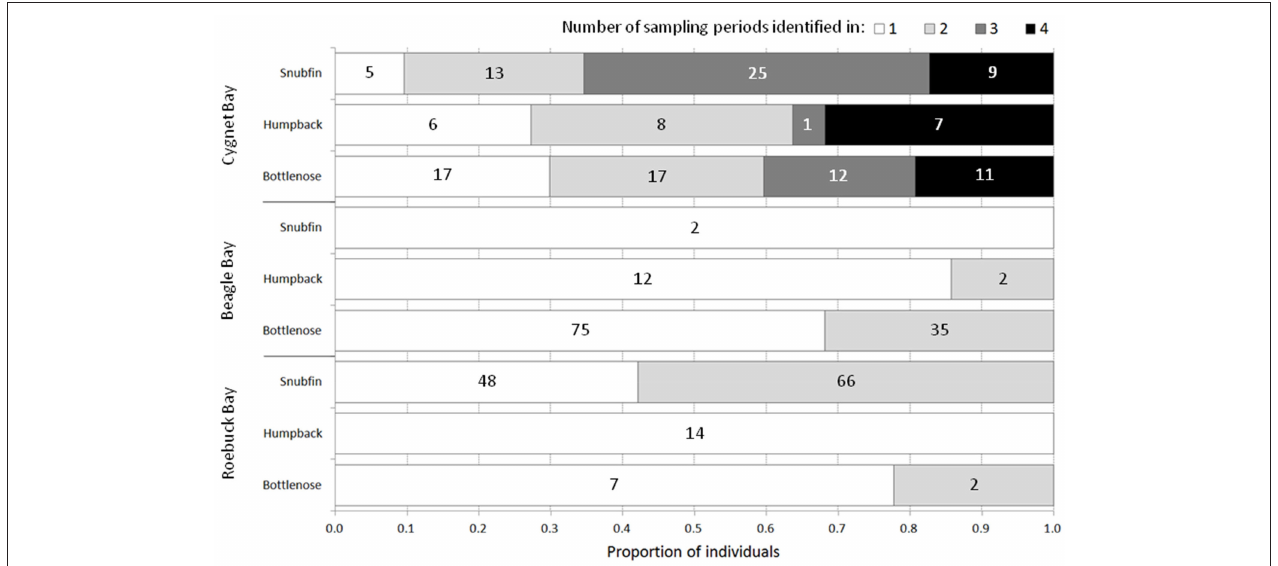
FIGURE 3 | The proportion of individuals sighted in 1, 2, 3, or 4 sampling periods (where applicable) at each study site. The total number of sampling periods per site is 4 (Cygnet Bay) and 2 (Beagle Bay, Roebuck Bay). Numbers on bars represent the number of individuals per category.